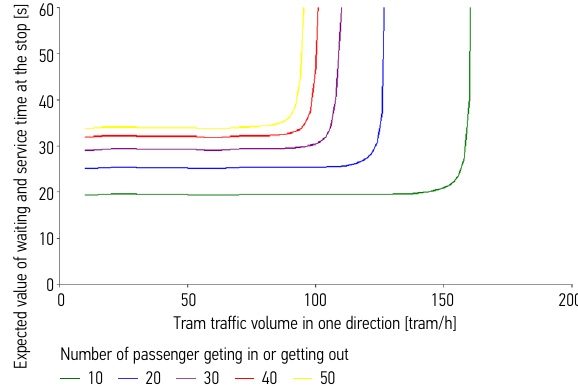
Fig. 6. Expected value of waiting and service time at the